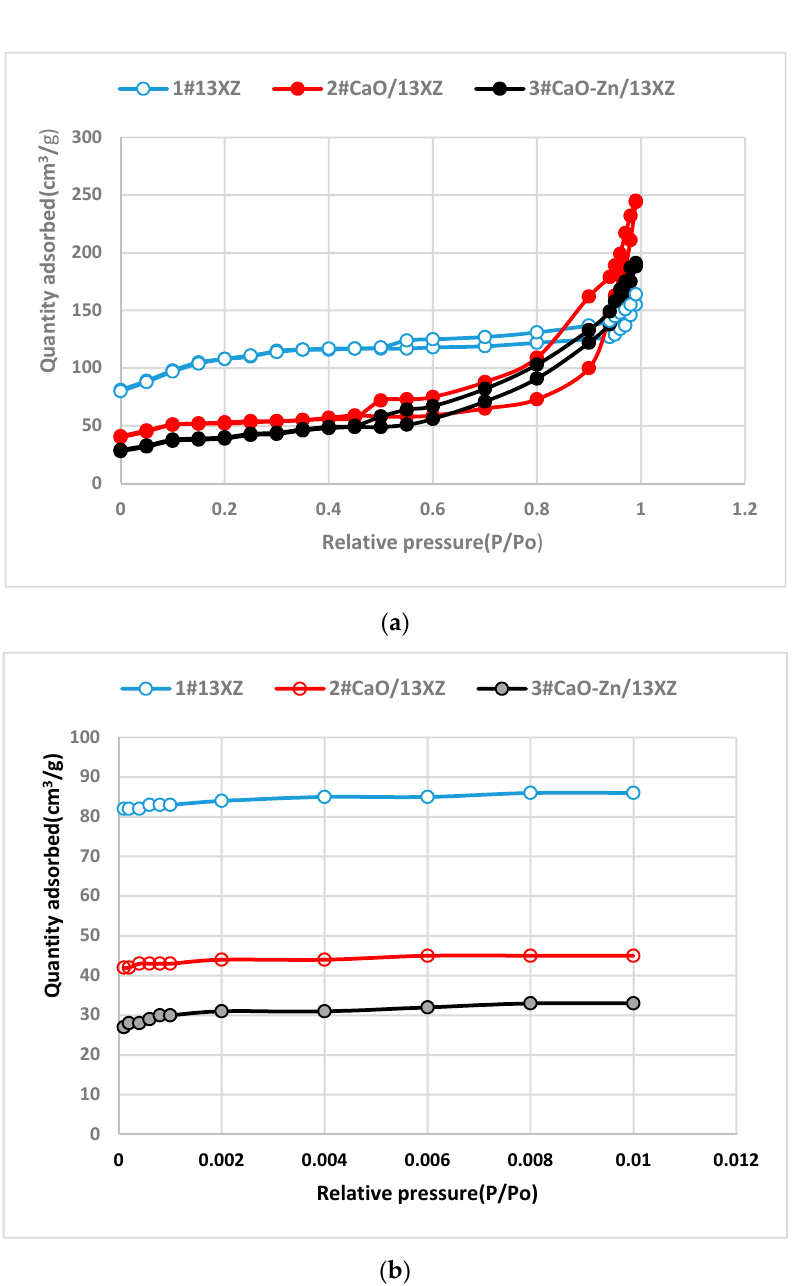
Figure 5. N 2 adsorption/desorption isotherms for 1# 13XZ, 2# CaO/13XZ and 3# CaO-Zn/13XZ nanocomposites; ( a ) adsorption/desorption isotherms at relative pressure P/P o in the range 0 to 0.99; ( b ) adsorption isotherms at relative pressure P/P o in range 0 to 0.01.